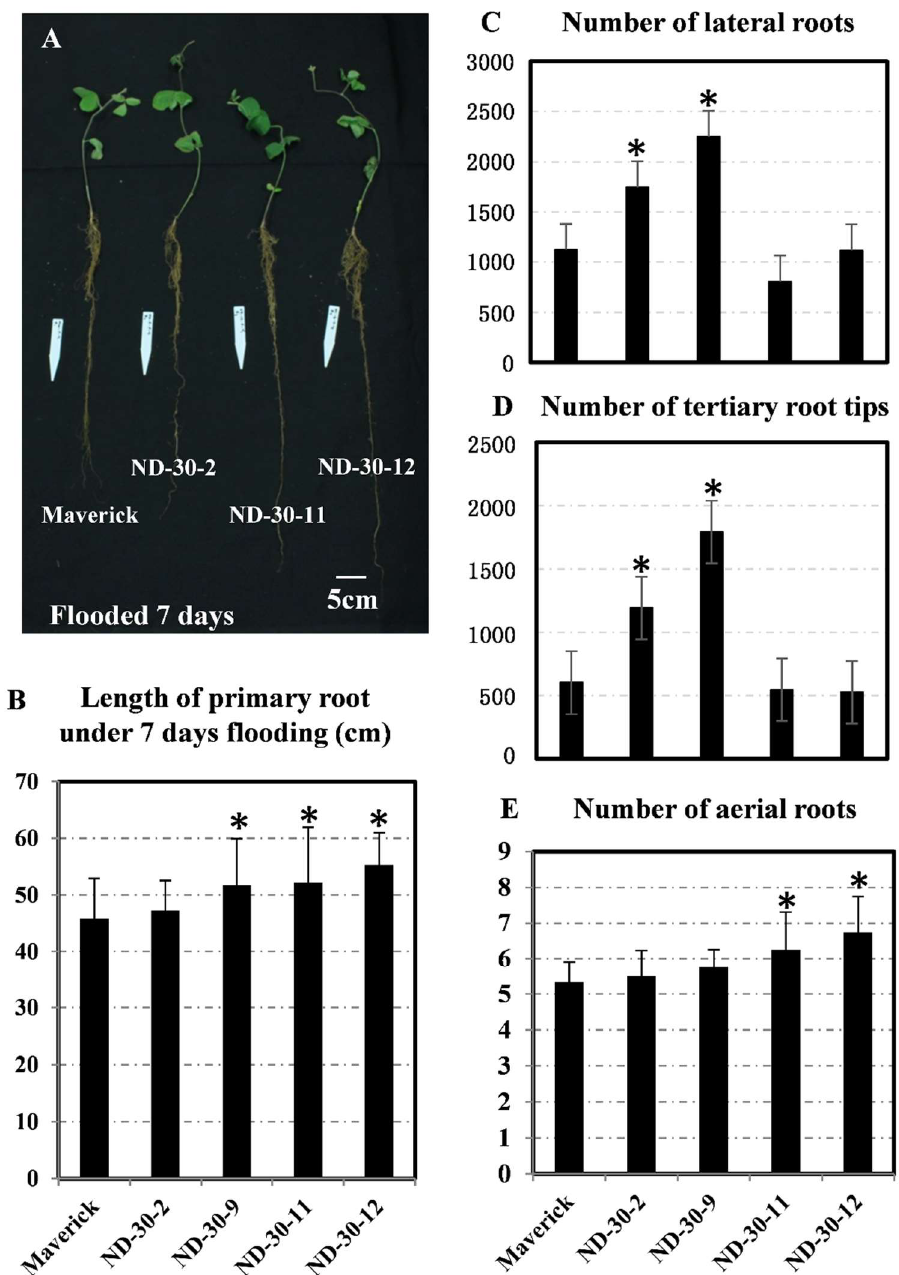
Figure 8. Soybean AtXTH31 transgenic plants show an enhanced flooding tolerance phenotype by promoting adventitious roots, lateral roots, tertiary root tips, and elongated primary roots. ( A ) Flooding effects on soybean seedlings. The V1 stage seedlings were flooded with water for 7 days. Bar indicates 5 cm. ( B ) Length of primary root compared between transgenic and control soybean plants under 7 days of flooding conditions. ( C – E ) The effects of flooding on number of lateral roots, tertiary root tips and adventitious roots per transgenic plant. ( n ≥ 20). * indicates differences between the maverick and transgenic soybean ( p < 0.05).